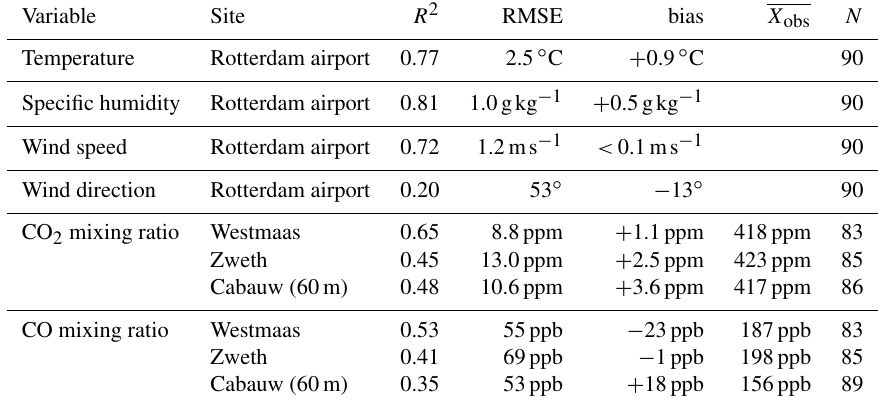
Table 3. Statistics for WRF-Chem daytime (08:00–17:00LT) average meteorological variables and total CO 2 and CO mixing ratios as compared to observed daytime averages (full simulation period). X obs is the average observed mixing ratio and N gives the number of days included. This table shows that WRF-Chem is able to represent day-to-day variations in meteorological conditions and mixing ratios, except for the wind direction.